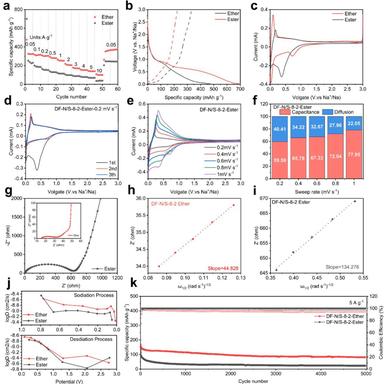
Na+ storage performance of DF-N/S-8–2-800℃ as the half-cell anode in ether- or ester-based electrolyte. (a)Rate performance; (b) Galvanostatic charge/ discharge curve for the first cycles at 0.05 A/g; (c-d) CV curves for the initial cycles in different electrolytes at a scan rate of 0.2 mV s − 1 ; (e) CV curves in different electrolytes at a scan rate of 0.2–1 mV s − 1 ; (f) The contribution ratio of the capacitive capacity at different scan rates in ester-based electrolyte; (g) EIS analysis; (h, i) σ value